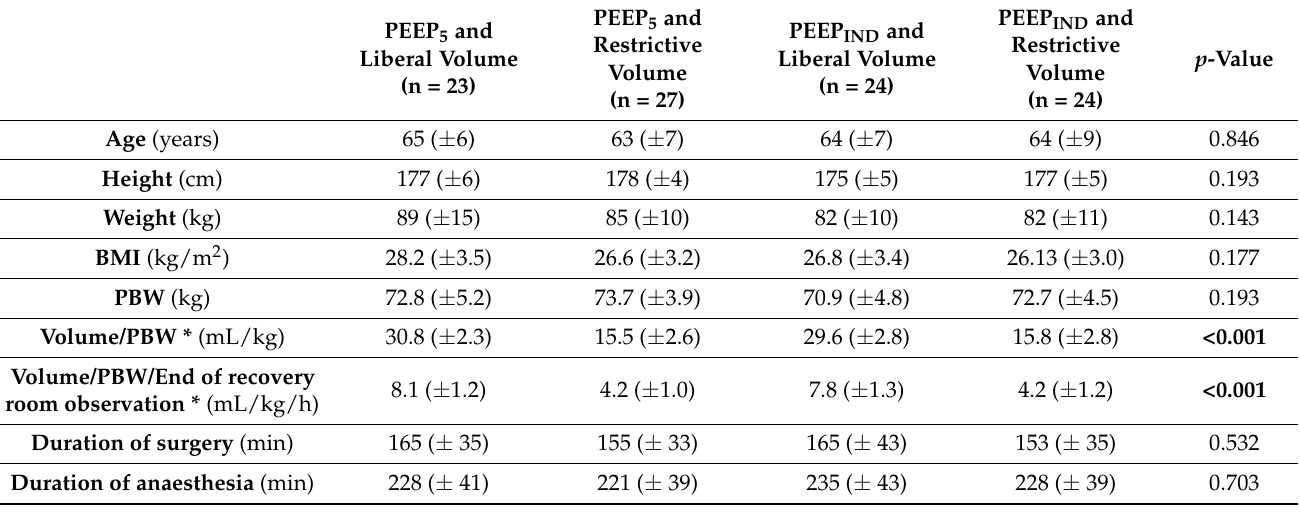
Table 1. Baseline patient and surgical characteristics (n =